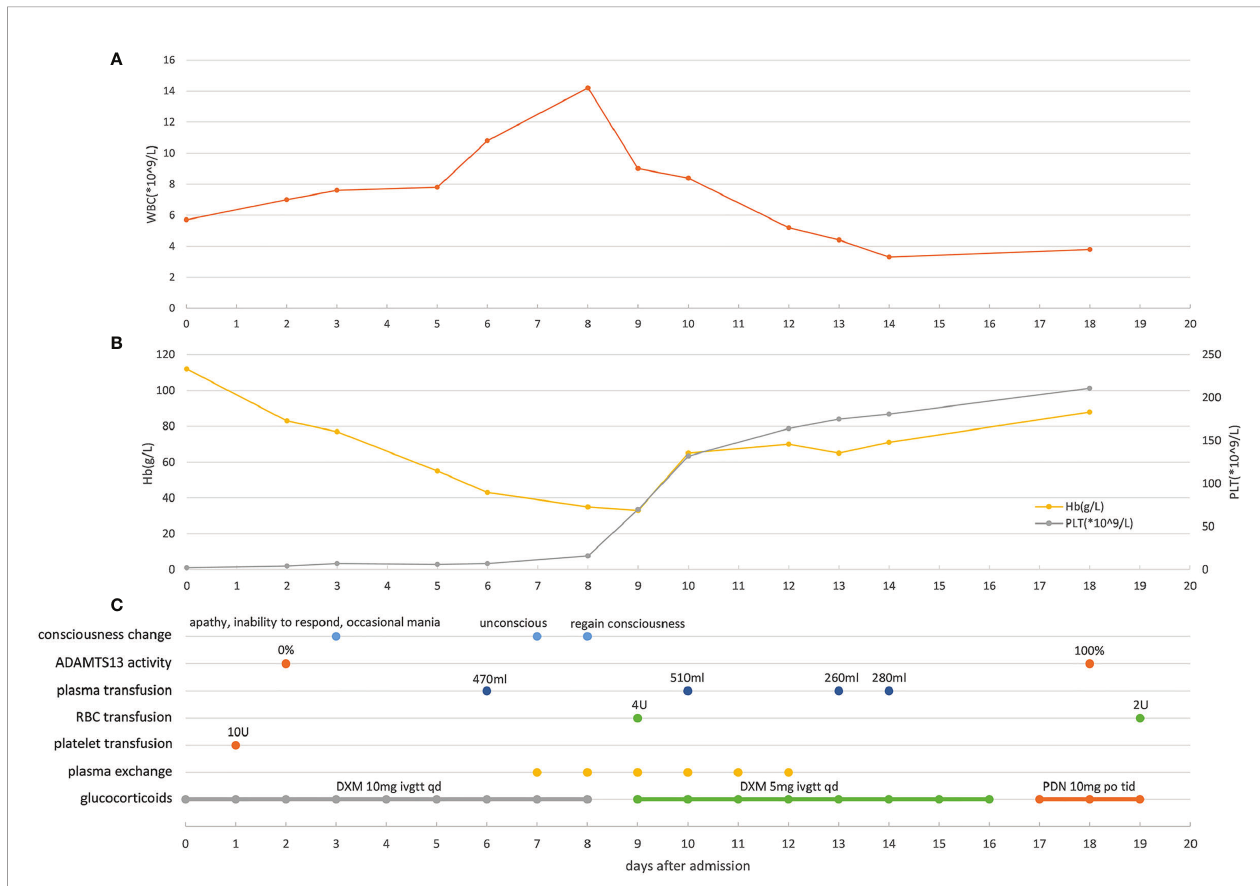
FIGURE 1 | Main clinical manifestations, test results, and treatment related to TTP (A) Changes of white blood cell counts in peripheral blood of the patient during hospitalization. (B) Changes of hemoglobin and platelet in peripheral blood of the patient during hospitalization. (C) Changes of the patient ’ s consciousness, ADAMTS13 activity and timepoints of applying plasma transfusion, red blood cell transfusion, platelet transfusion, plasma exchange and glucocorticoids. WBC, white blood cell; Hb, hemoglobin; PLT, platelet; RBC, red blood cell. ADAMTS13, metalloprotease with thrombospondin type I motif, member 13; DXM, dexamethasone; PDN,